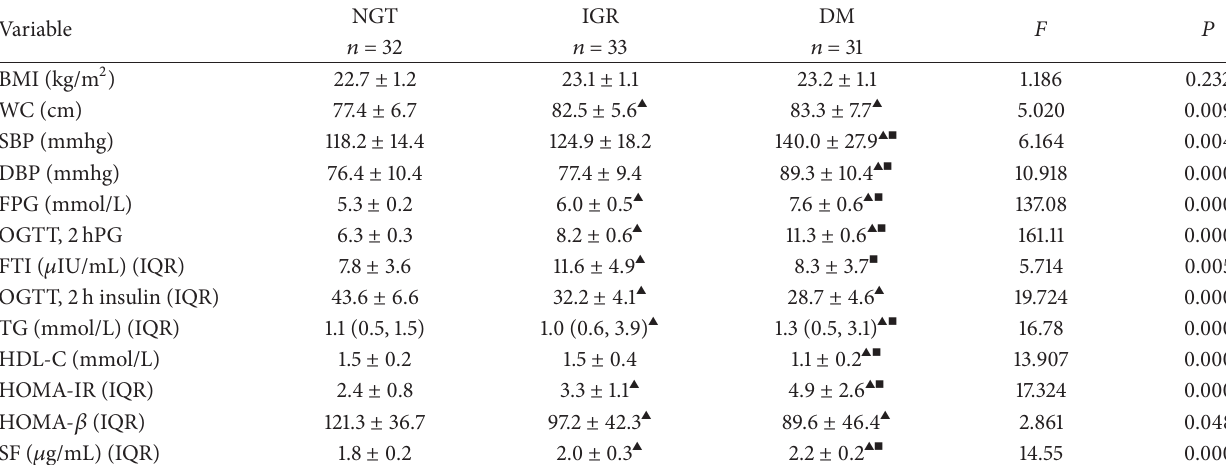
Table 1: Clinical and laboratory characteristics of the subjects in different groups.